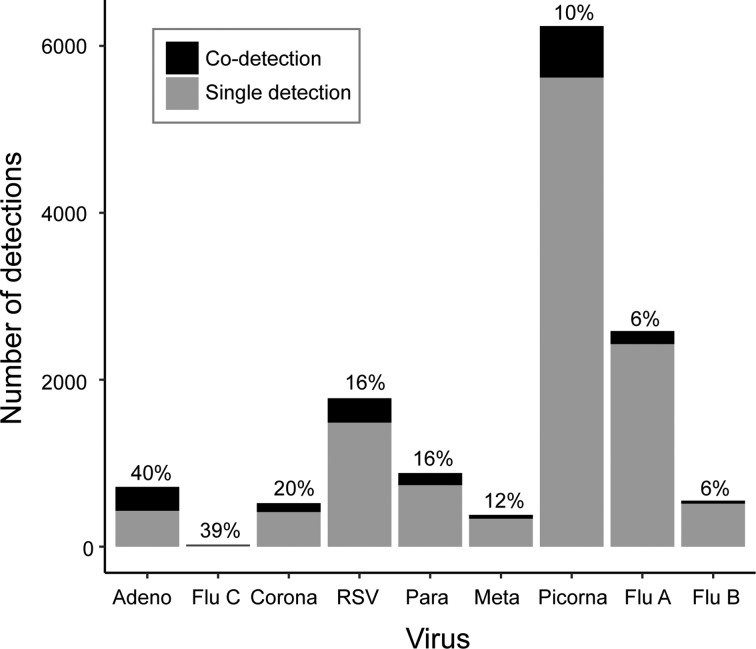
Viral co-detections.